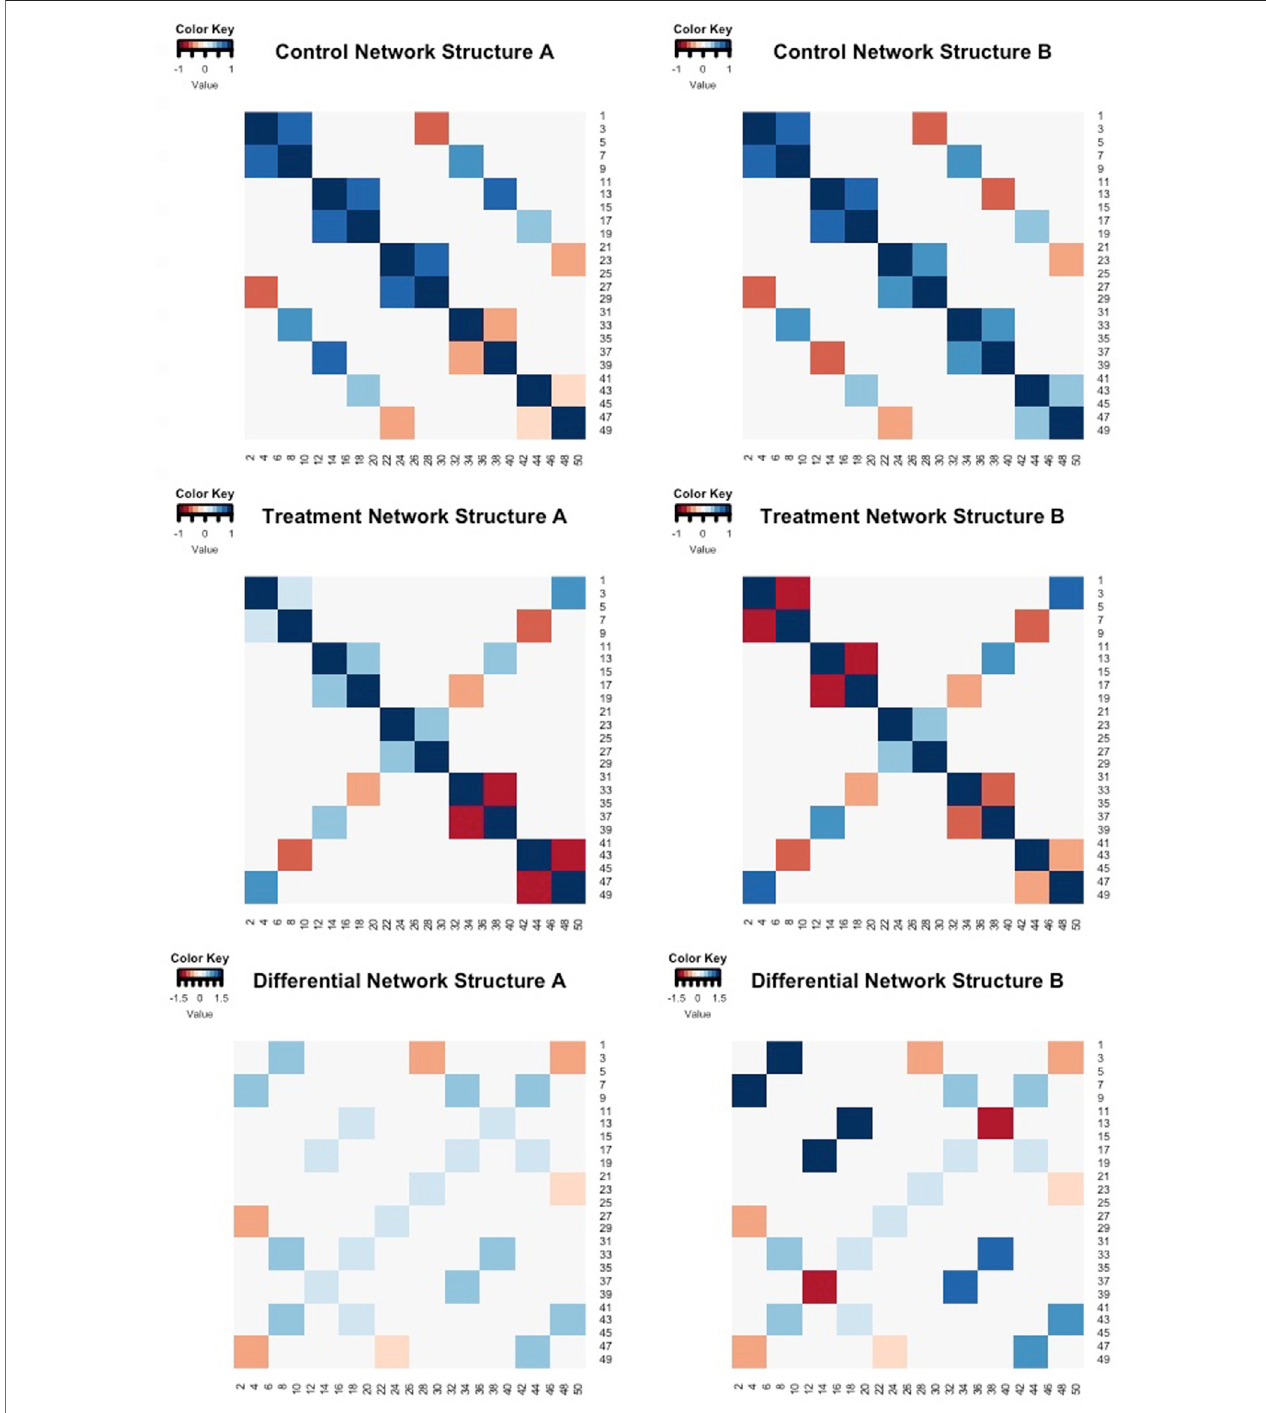
FIGURE 2 | Heatmaps of the “ true ” correlation structures of control group (row 1) and treatment group (row 2) for Network Structure A and Network Structure B. Thecoloredcellsintheseheatmapsrepresentthemagnitudeanddirectionofgene-genecorrelations.Row3containsthedifferencesbetweenthecontrolandtreatment correlation structures. The colored cells in row 3 indicate the magnitude and direction of the differences in gene-gene associations across the two groups (control - treatment).